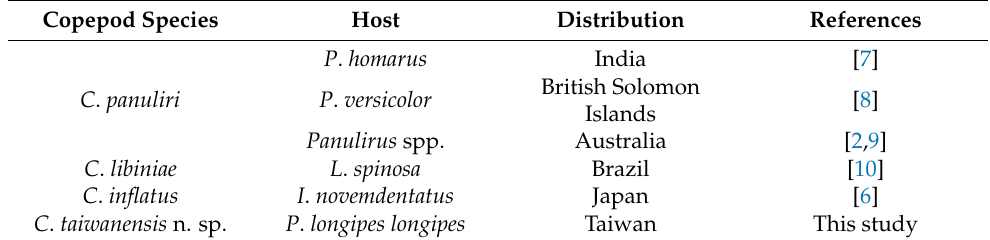
Table 1. The information of four Choniomyzon copepods parasitic on decapod hosts. Copepod